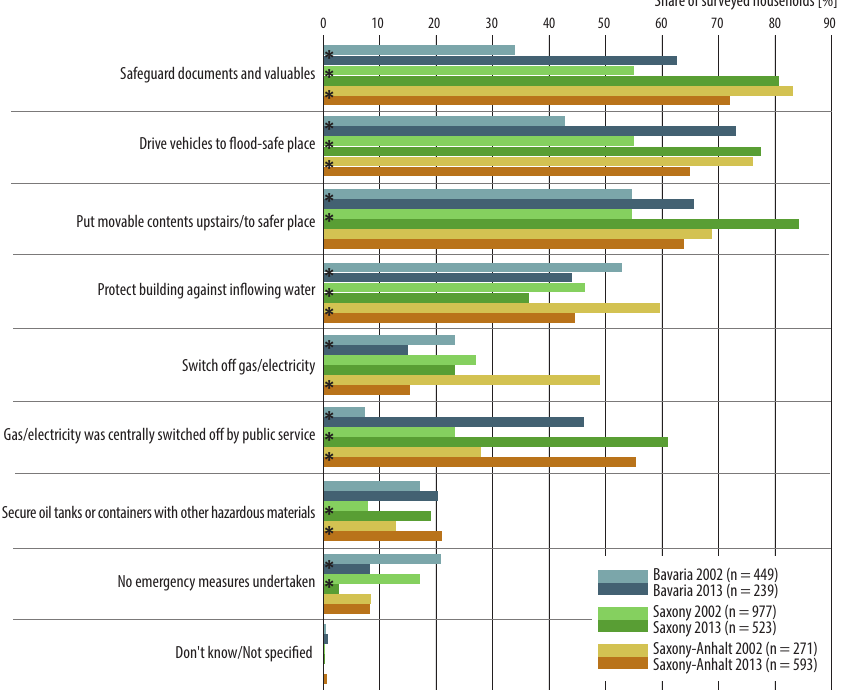
Figure 7. Overview of the emergency measures undertaken by the interviewed households in Bavaria, Saxony and Saxony-Anhalt (semi-open question, multiple answers possible, ∗ indicates significant differences ( p <0.05) between 2002 and